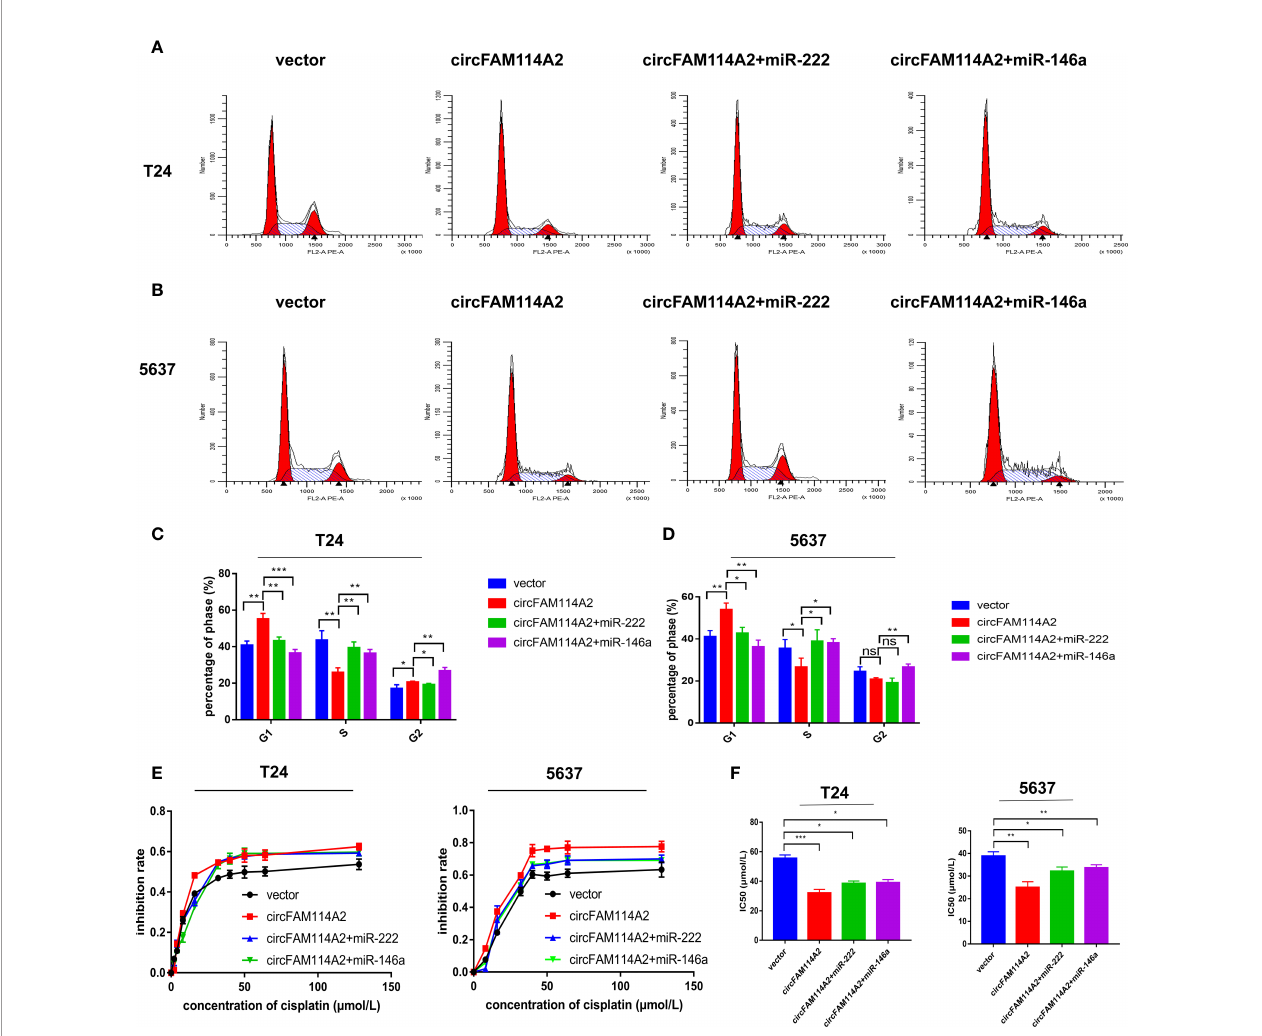
FIGURE 5 | MIR-222-3p/146a-5p interference rescued the cell cycle arrest and cisplatin chemosensitization induced by circFAM114A2 in urothelial carcinoma cells. (A) Illustrations of the fl ow cytometry assays in T24 cells. (B) Illustrations of the fl ow cytometry assays in 5637 cells. (C) More cells were distributed in the G1 phase and fewer cells were distributed in the S phase in the circFAM114A2 overexpression group compared with the control group in T24 cells, and miR-222-3p and miR- 146a-5p mimic transfection could reverse the G1 phase redundant and reduced S phase (Student ’ s t -test: * p < 0.05, ** p < 0.01, *** p < 0.001). (D) More cells were distributed in the G1 phase and fewer cells were distributed in the S phase in the circFAM114A2 overexpression group compared with the control group in 5637 cells, and miR-222-3p and miR-146a-5p mimic transfection could reverse the G1 phase redundant and reduced S phase (Student ’ s t -test: * p < 0.05, ** p < 0.01). ns, no signi fi cant. (E) The cell viability curve of the cisplatin treatment assays showed that miR-222-3p/miR-146a-5p mimics could reverse the high inhibition rate induced by circFAM114A2 in T24 and 5637 cells. (F) IC 50 values showed that co-transfection with the miR-222-3p or miR-146a-5p mimic could reverse the increased sensitivity to cisplatin induced by circFAM114A2 in T24 and 5637 cells (Student ’ s t -test: * p < 0.05, ** p < 0.01, *** p < 0.001). Data are the mean ± SD, n =